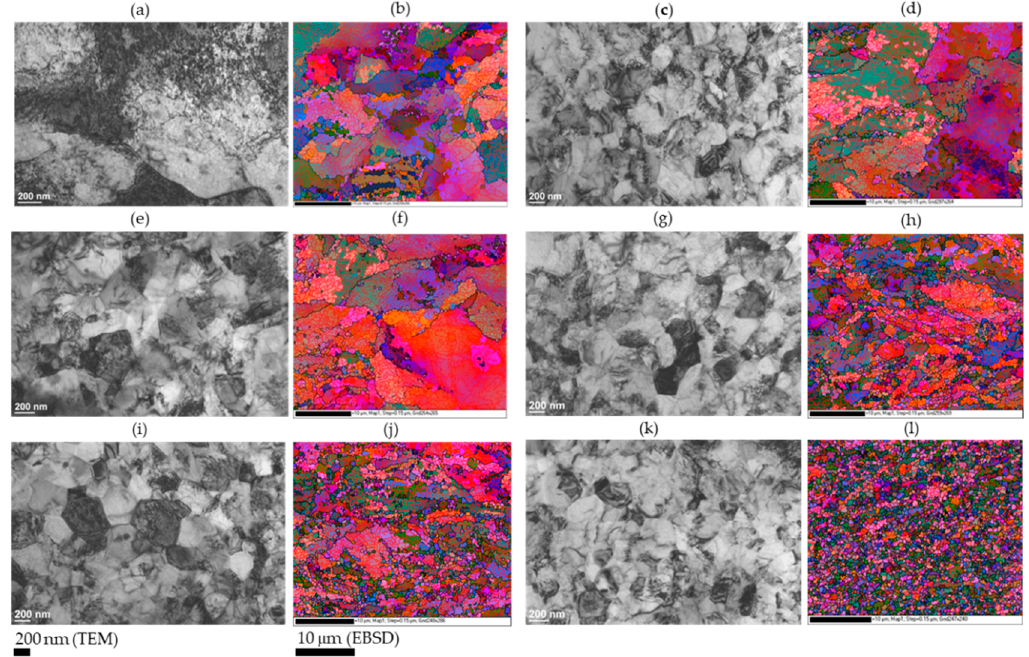
Figure 2. TEM micrographs (grayscale) and EBSD (Euler angle distribution color maps) results for HSLA steel deformed with total strains of 2 ( a,b ), 5 ( c,d ), 7 ( e,f ), 10 ( g,h ), 15 ( i,j ) and 20 ( k,l ). Black lines—high-angle grain boundaries (HABs); red lines—low-angle grain boundaries (LABs).